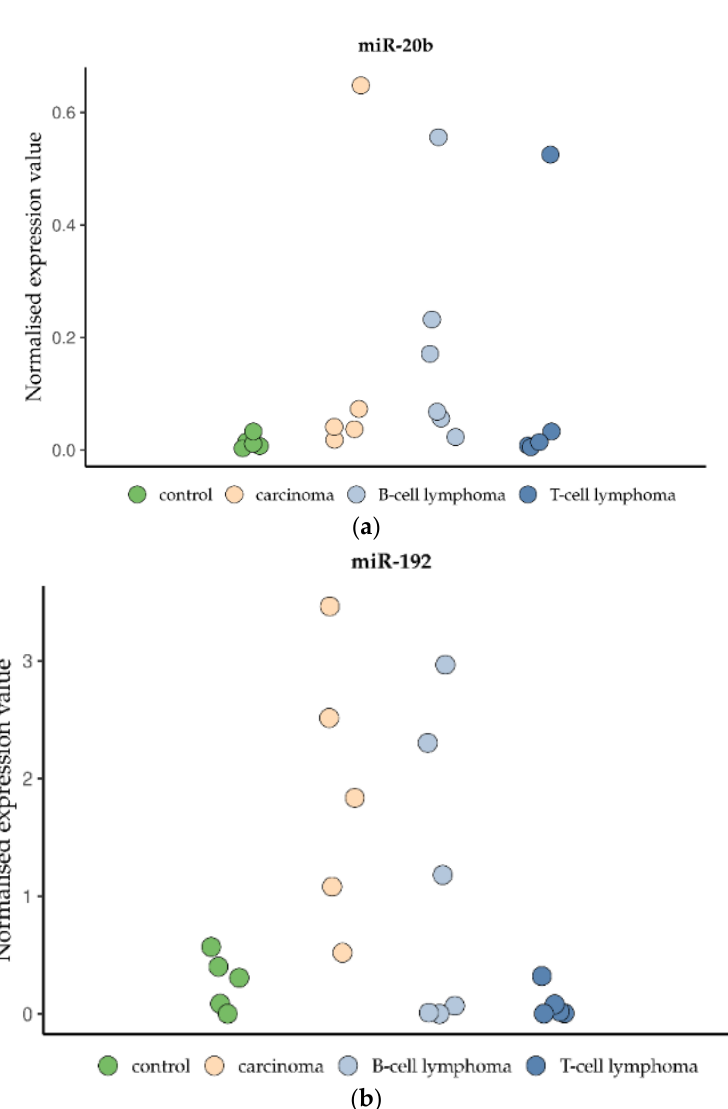
Figure 9. Expression levels of miR-20b ( a ) and miR-192 ( b ) in samples of small intestinal tubular carcinomas ( n = 5), large-cell B-cell lymphomas ( n = 6) and small-cell T-cell lymphomas ( n = 5) versus normal intestinal control tissue ( n = 5). Absolute quantification was carried out by ddPCR. The absolute miRNA copy number was related to the internal normaliser RNU6B. Results are shown as normalised expression values.